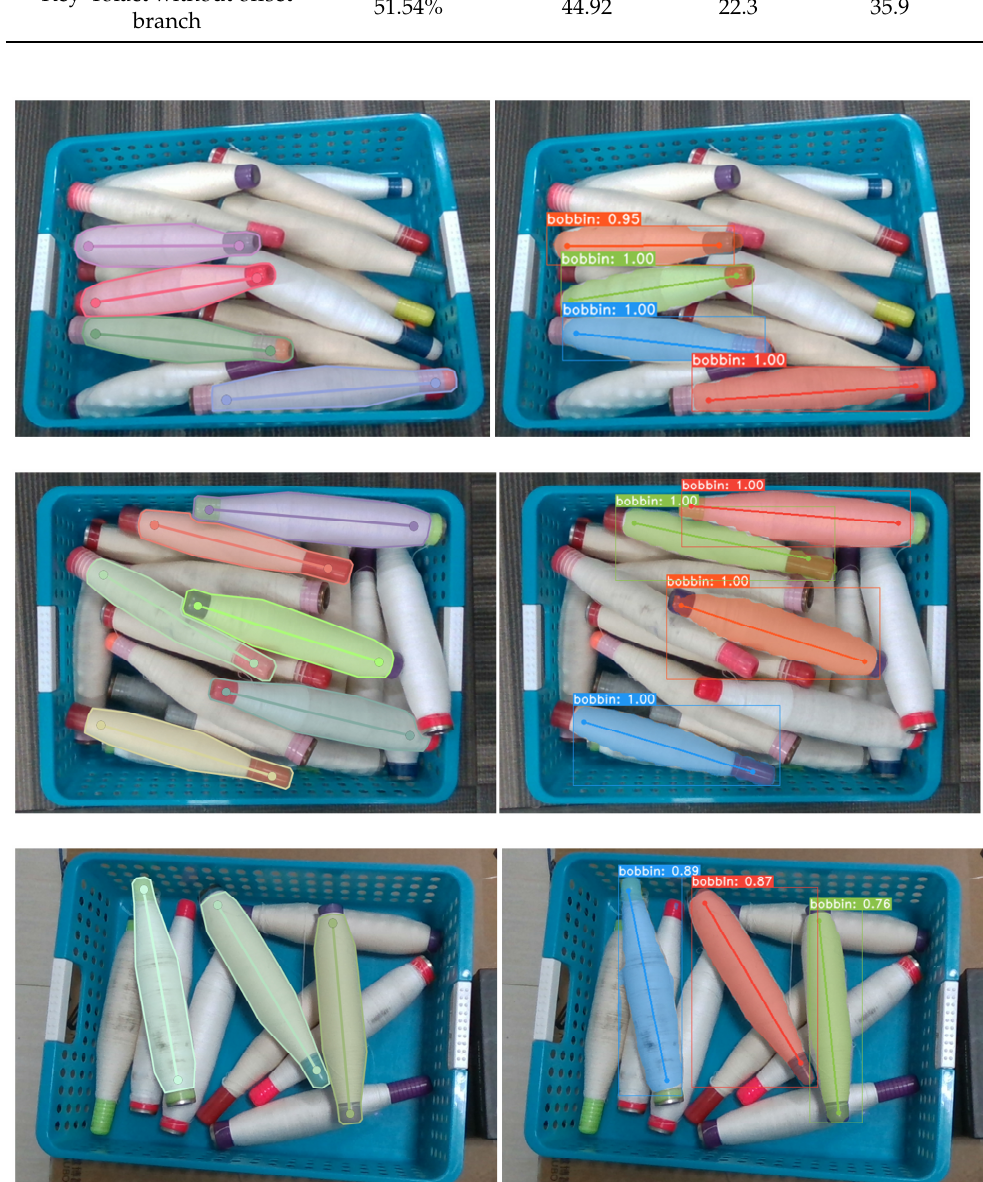
Figure 13. Results for validation set in self-built dataset. The images on the left show the ground truth, and those on the right show the prediction. The prediction in the first row was perfect. Two objects were not detected due to occlusion in the second row. The class confidences of the prediction were slightly lower, because there were slightly fewer images like this in the dataset, where the bobbins were sparsely distributed.